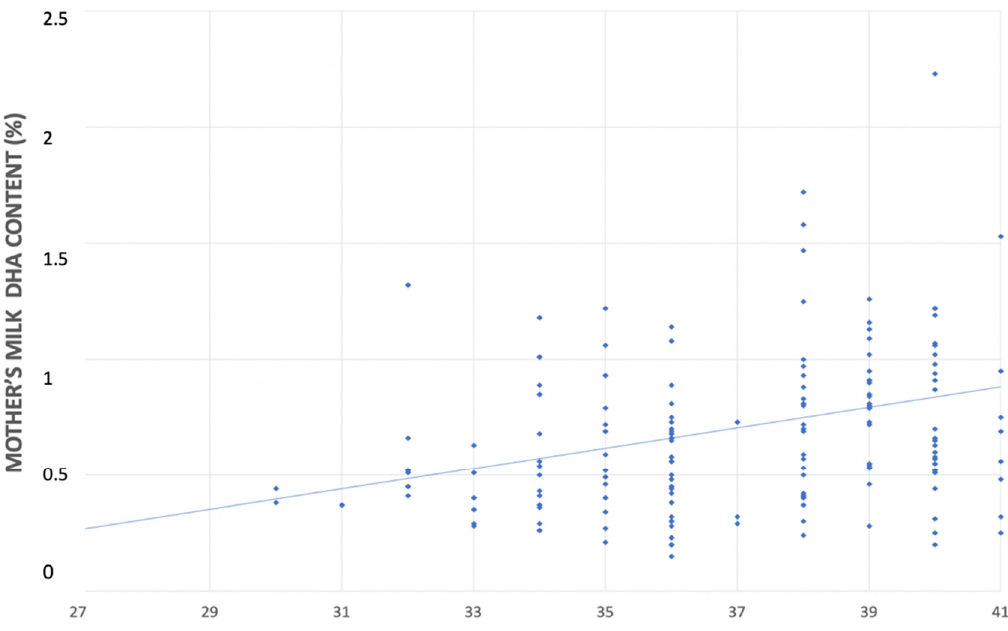
Figure 3. Relationship between mother’s milk DHA’s content (%) and gestational age (weeks).